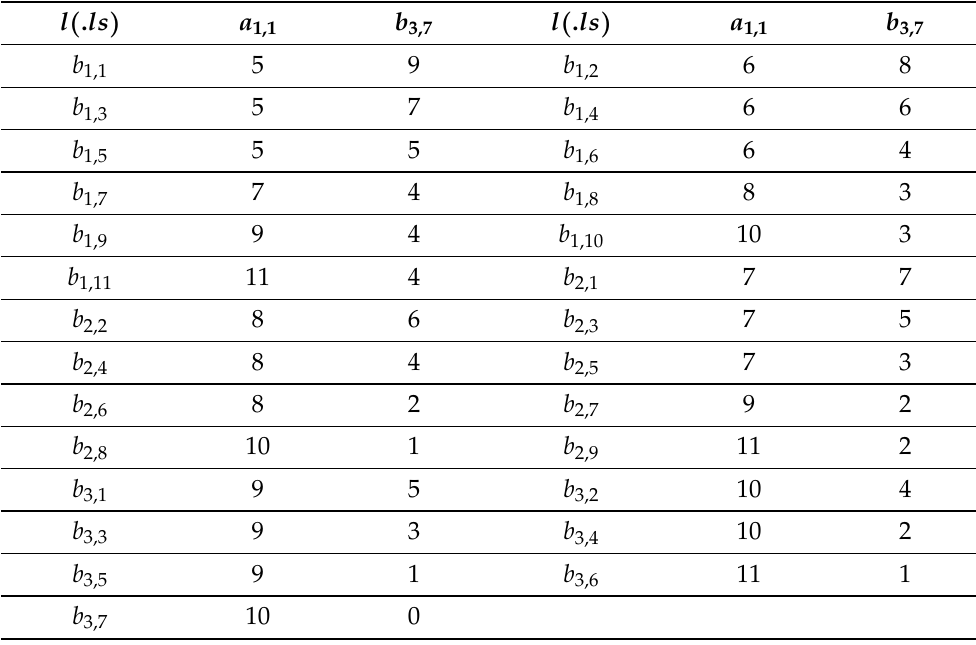
Table 6. Locations of the nodes of GHCN ( 3,3,3 )